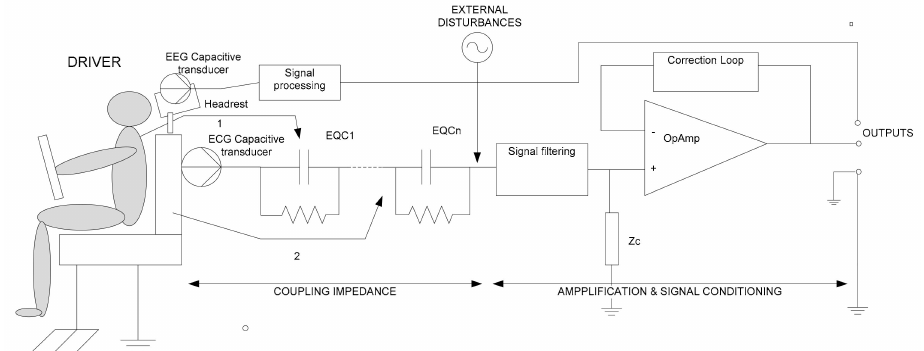
Figure 2. Electronic equivalent circuit of the measurement